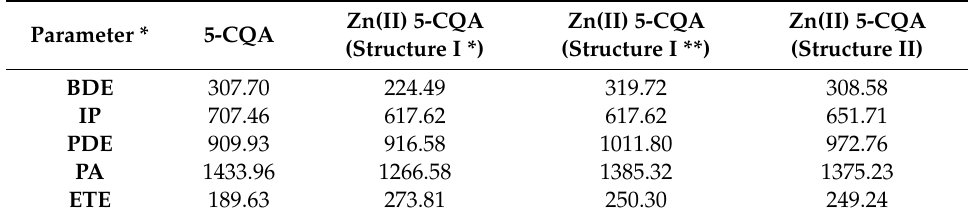
The bond dissociation enthalpies (BDE) (kJ / mol), ionisation potentials (IP) (kJ / mol), proton dissociation enthalpies (PDE) (kJ / mol), proton a ffi nities (PA) (kJ / mol), electron transfer